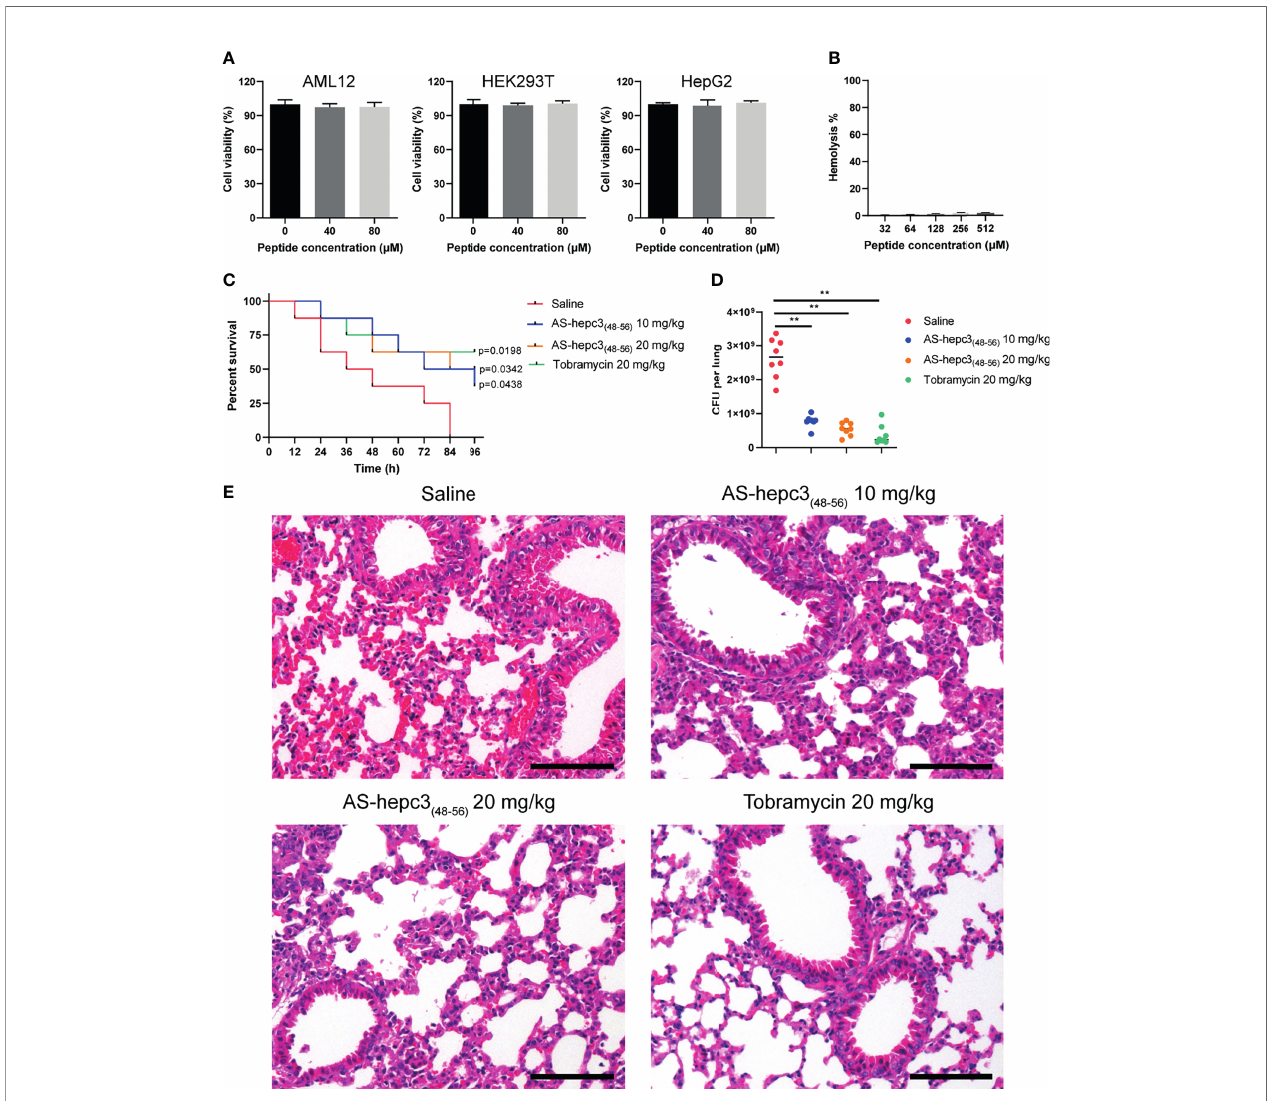
FIGURE 6 | AS-hepc3 (48-56) inhibits MDR P. aeruginosa lung infection and in fl ammation in vivo . (A) The cytotoxicity of AS-hepc3 (48-56) towards human cell lines. (B) The hemolysis activity of AS-hepc3 (48-56) was assessed by incubating with mouse red blood cells. (C) Following intratracheal inoculation of mice (C57BL/6, male, n= 8) with MDR P. aeruginosa QZ19125 and subsequent intratracheal instillation of AS-hepc3 (48-56) or sterile saline to evaluate the survival rates by Kaplan – Meier survival curve. (D) The bacterial burden in lung homogenate was shown. (E) Representative histopathological images of processed lung section with hematoxylin and eosin (H&E) after treatment with sterile saline, AS-hepc3 (48-56) , or tobramycin. Scale bars, 100 µm. Data are shown as means ± SD and statistical signi fi cance was determined by one-way ANOVA with Tukey ’ s multiple comparisons. ** P <